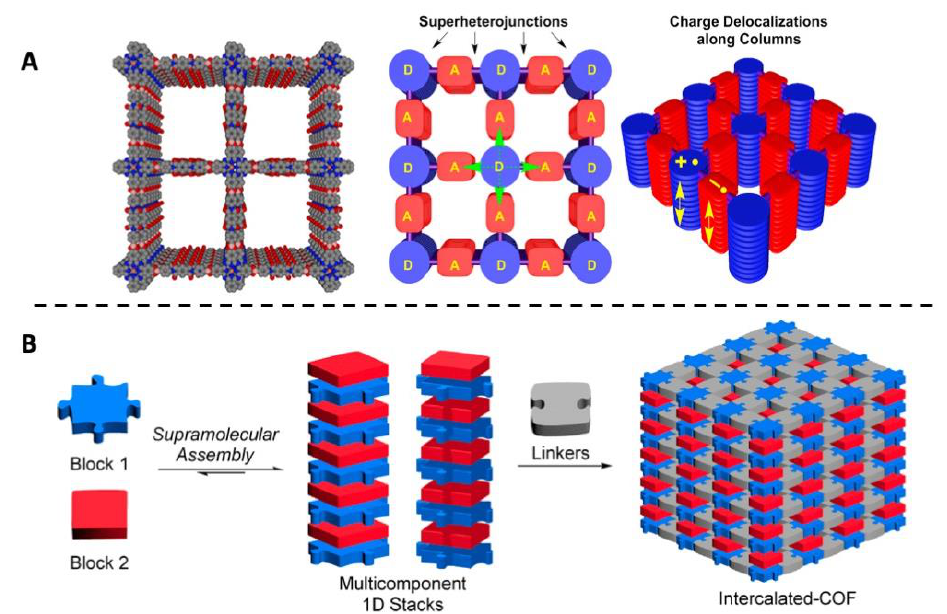
Figure 6. Donor-Acceptor COF structures: ( A ) Eclipsed donor-acceptor stackings of common COFs and their perfectly separated bicontinuous electron-hole columns (reproduced from Ref. [100] with permission from American Chemical Society) ( B ) Electron poor COF sheets intercalated with electron-donating moieties (acceptor = blue, crosslinker = gray, donor = red, reproduced from Ref. [104] with permission from American Chemical Society).